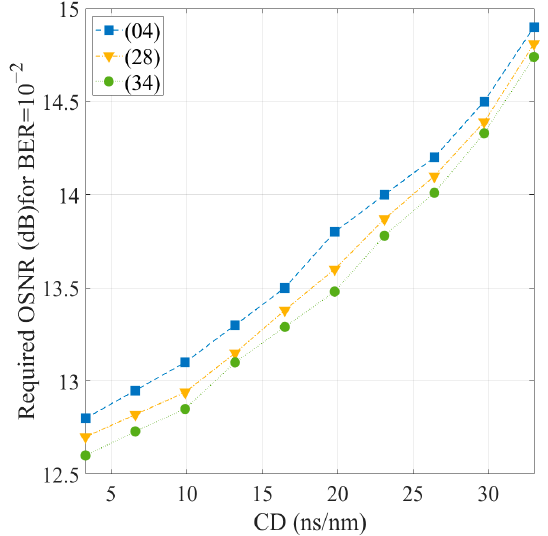
Figure 6. The OSNR penalty performance of the 64 GBaud DP-QPSK data.